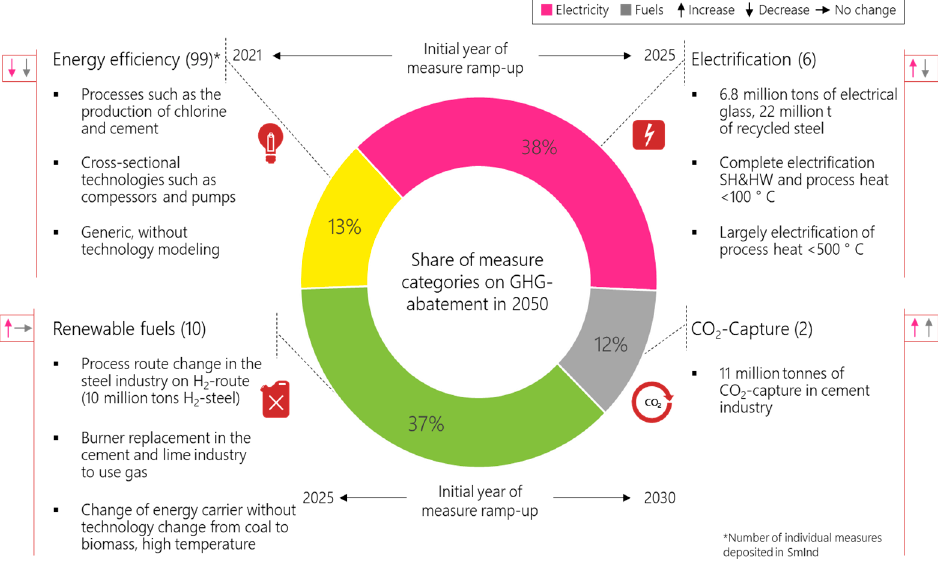
Figure 10. The four major levers for reducing GHG emissions in industry.